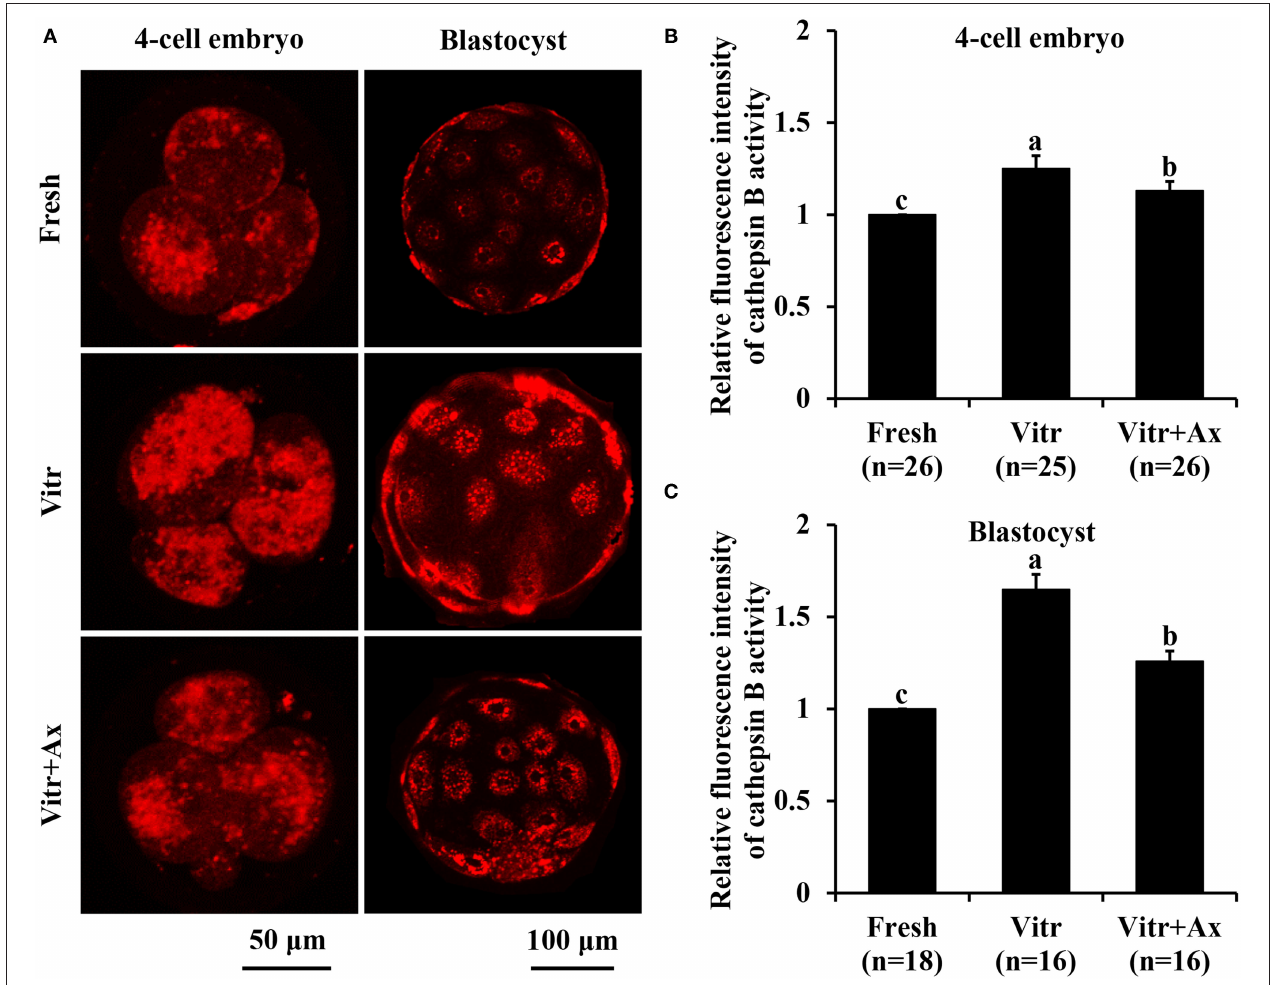
FIGURE 7 | Effects of astaxanthin (Ax) supplementation on intracellular cathepsin B activity in resultant 4-cell embryos and blastocysts. (A) Representative images of cathepsin B signals stained with MR-RR2. (B,C) Graphical representation of cathepsin B activity by quantifying the relative fluorescence intensity. Four replications were performed. Data are the mean ± SEM values. Different superscripts above columns indicate significant differences ( P < 0.05). The three experimental groups: fresh zygotes (Fresh group), vitrified zygotes (Vitr group), and vitrified zygotes cultured with Ax (Vitr + Ax